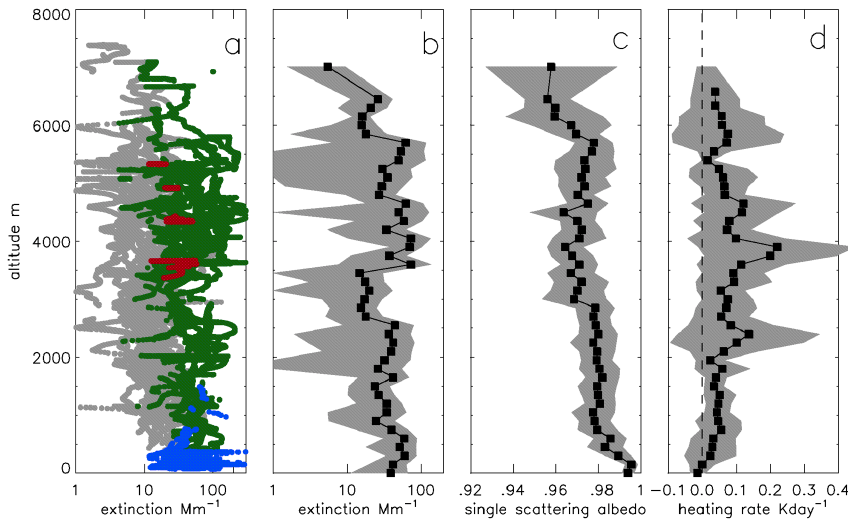
Fig. 14. (A) Vertical profiles of ambient aerosol extinction determined from dry extinction measurements corrected to ambient humidity and air density. Biomass burning (green points), Arctic sea-ice boundary layer (blue), background (grey), and anthropogenic (red) airmass classifications. (B) Data from (A) averaged into 150m altitude bins. (C) Aerosol single scattering albedo averaged into 150m increments. (D) Calculated instantaneous noontime heating rate given by average profiles in (B) and (C) and other parameters as specified in text. Grey shading indicates one standard deviation for each 150m